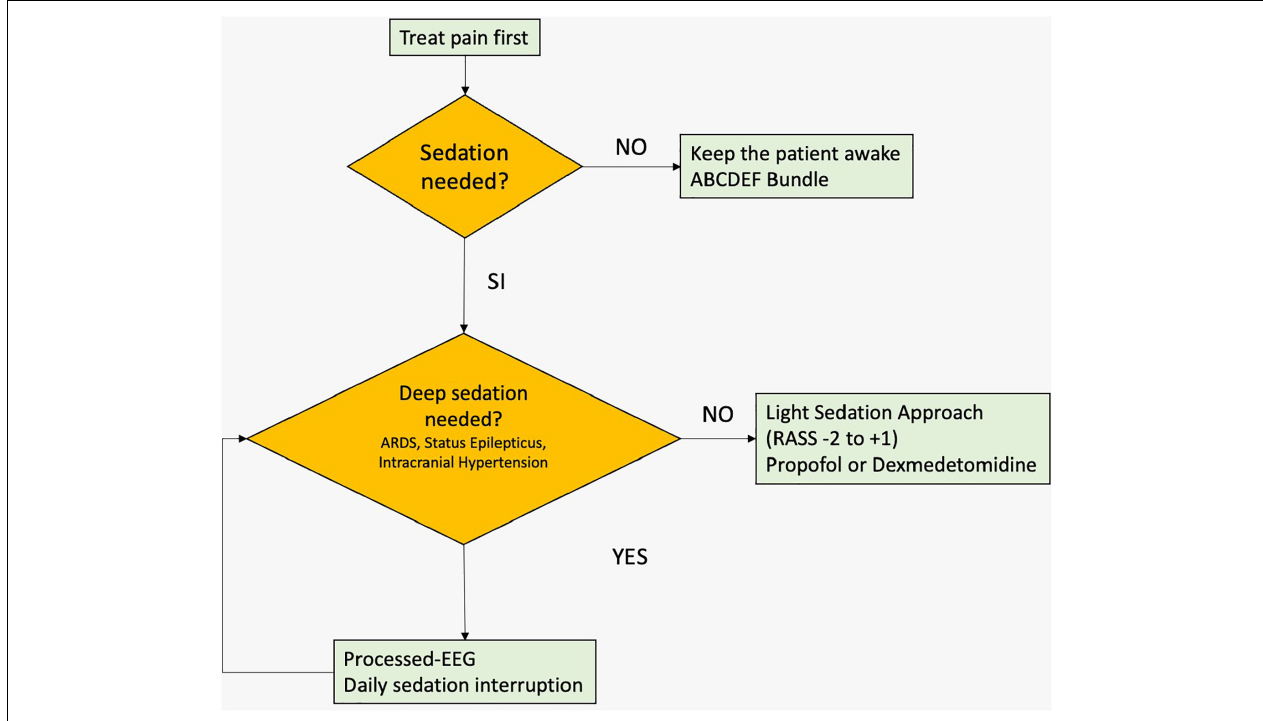
FIGURE 1 | Algorithm for the use of sedation in critically ill patients. ARDS, acute respiratory distress syndrome; RASS, Richmond Agitation–Sedation